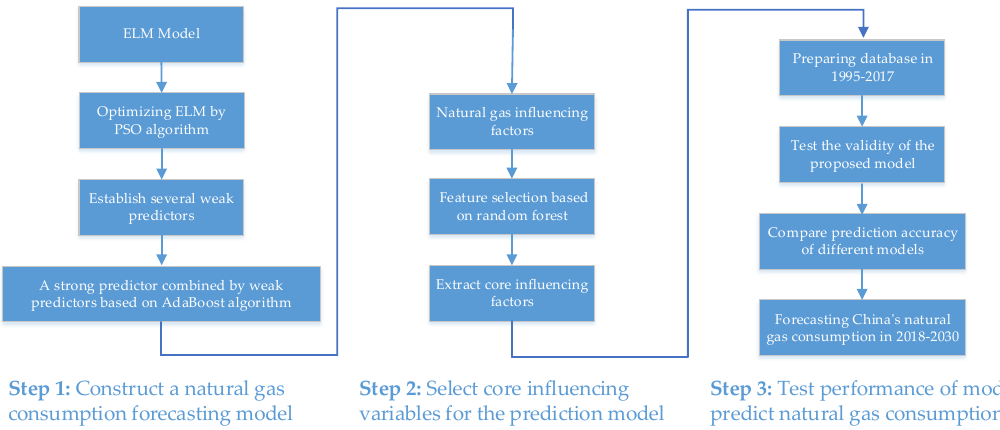
Figure1 . The flow chart of this study. ELM: extreme learning machine; PSO: particle swarm optimization.